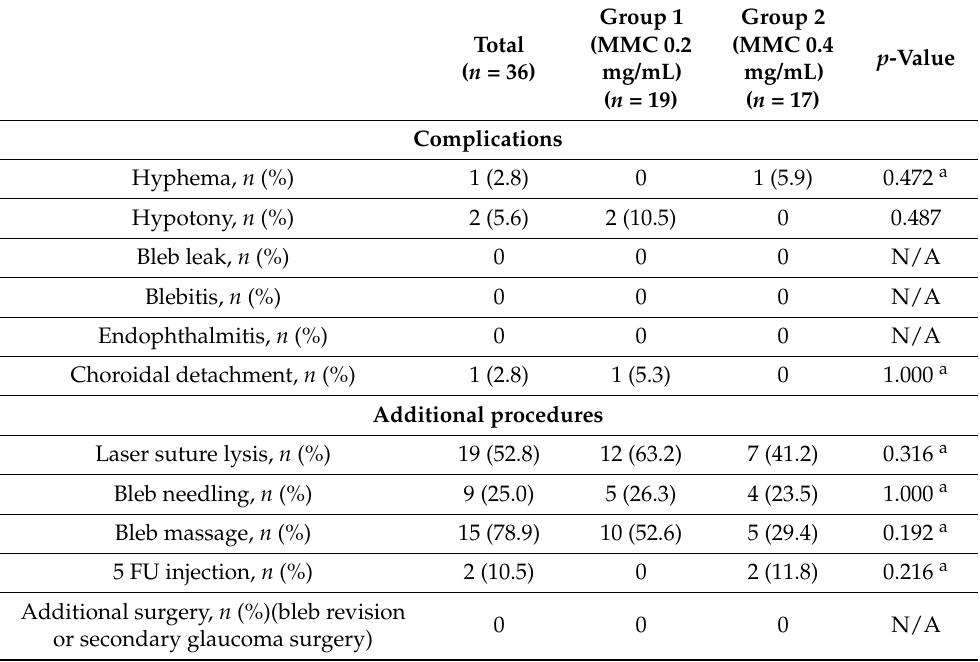
Table 5. Postoperative complications and additional